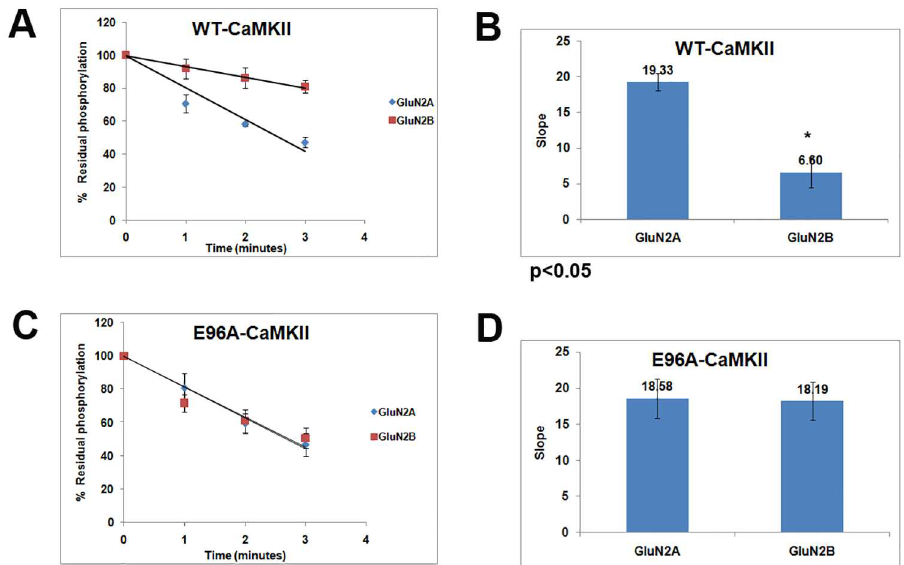
Fig 3. Comparison of the effectof GluN2Bon the ratesof dephosphorylationof WT and E96A. A and C: The extent of dephosphorylationof WT and E96A mutantof α -CaMKIIwere determined at 1, 2 and 3 minutesin presenceof GST-S1303A-GluN2Bor GST-S1291A-GluN2A.Phosphorylationintensitywithout PP1 at 0 timewas taken as 100%. The values plottedwere fromthe densitometricdata of autoradiographic imagesas shown in S5 Fig, fromthreeexperiments. B and D: The slope values of the plots of the time course of dephosphorylationin presenceof GluN2B and GluN2Asequencesare presentedas the bar graphs (For B, p < 0.05 in a two—tailed student’s